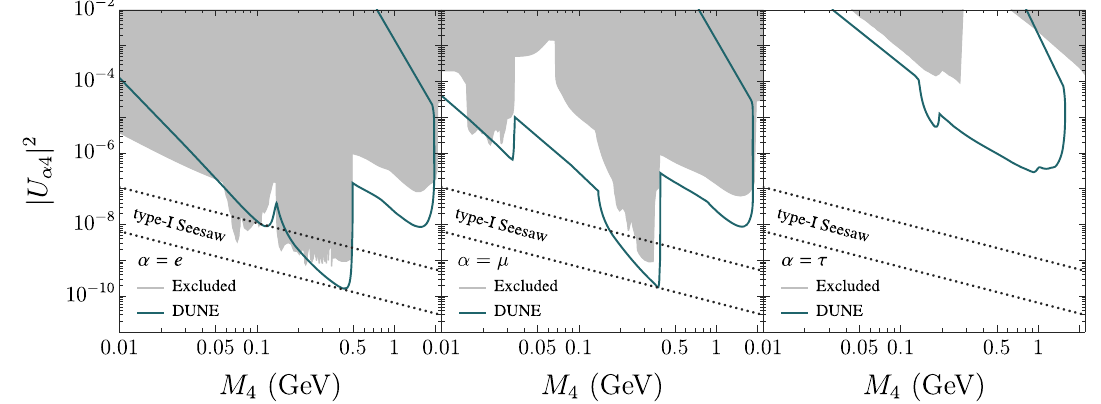
Fig. 7 Expected DUNE sensitivity (at 90% CL) to the mixing matrix elements | U α 4 | 2 as a function of the heavy neutrino mass, for a total of 7 . 7 × 10 21 PoT collected, combining all possible decay channels for the HNL leading to visible final states in the detector. Results are shown for a HNL coupled to e (left panel), μ (middle panel), and τ (right panel). The shaded gray areas are disfavored at 90% CL by present exper-